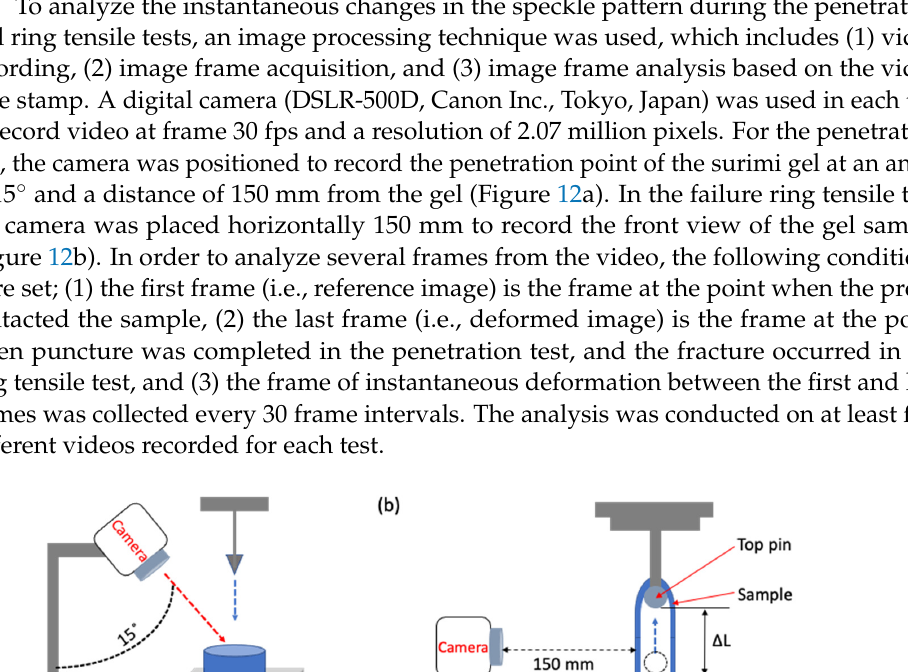
Figure 13. Geometry description of surimi gel during numerical analysis ( a ), and mesh model ( b ).